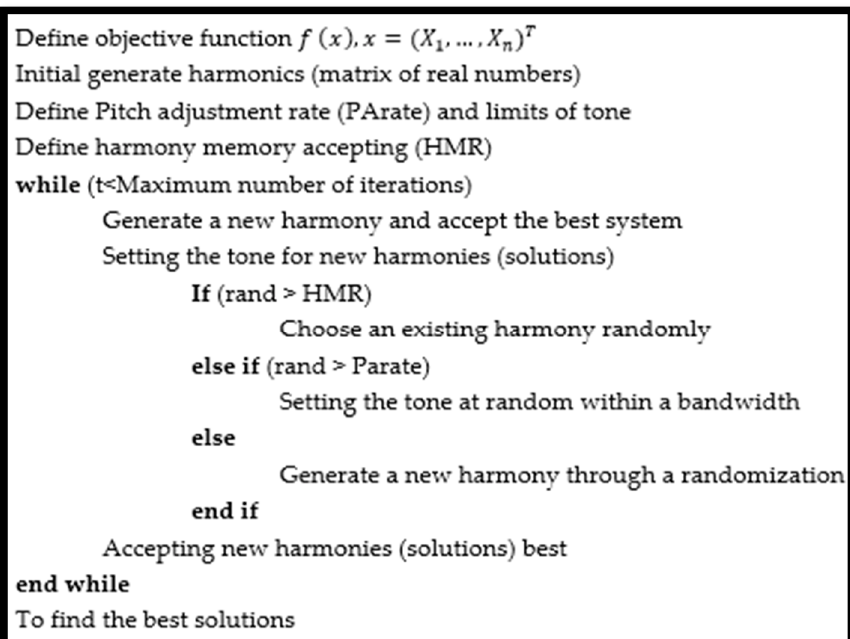
Algorithms 2018 , 11 , x FOR PEER REVIEW Figure 15. Harmony search algorithm. Figure 15. Harmony search algorithm.